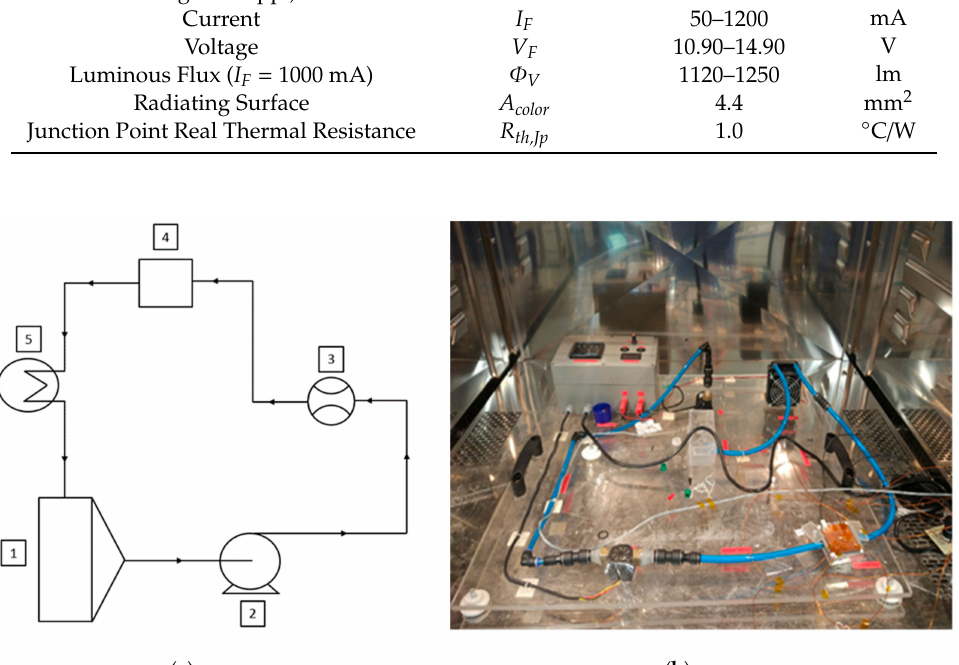
Figure 4. Experimental set-up: ( a ) Schematic view of water recirculation cycle; ( b ) Photograph of the test